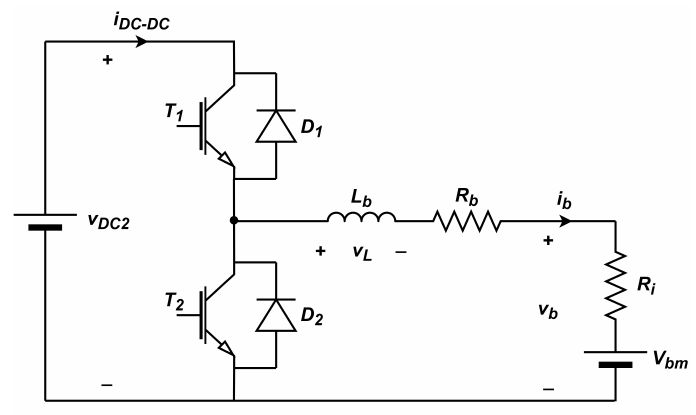
Figure 5. Bidirectional step-down DC–DC converter connected to the battery of the